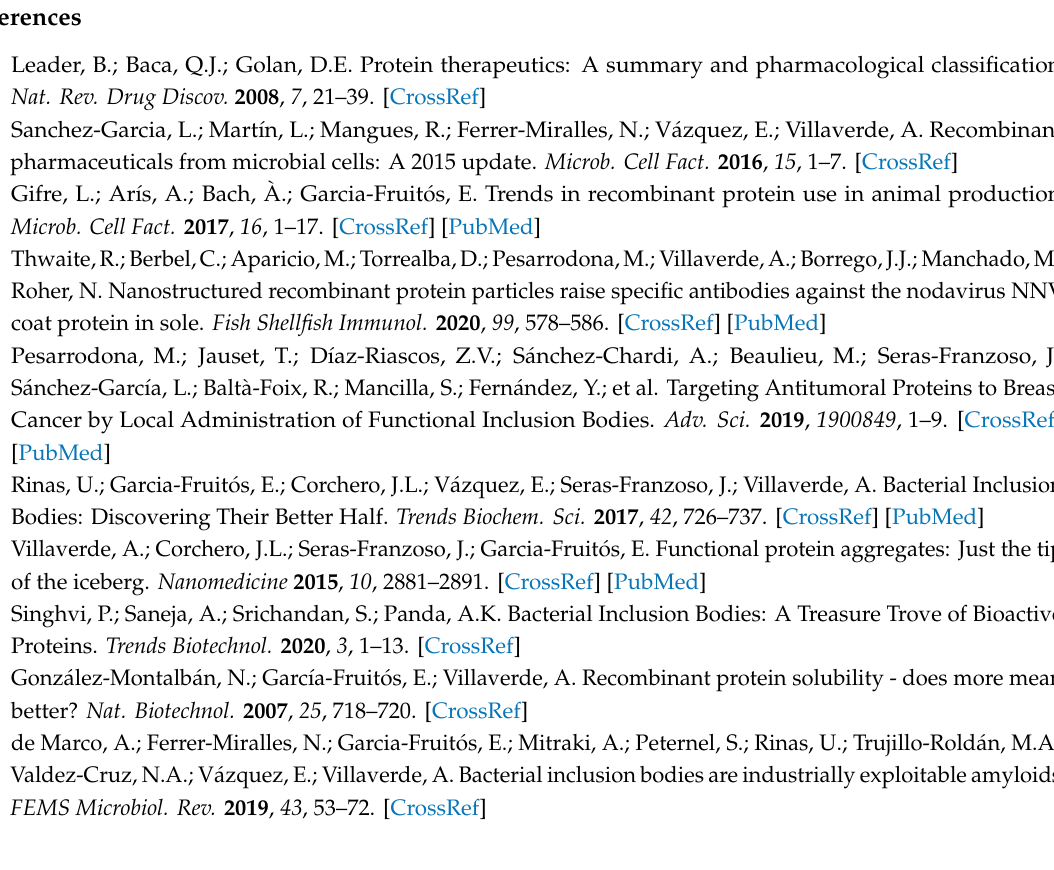
Figure S1: Schematic representation of the protocol used to obtain MMP-9 in L. lactis in both soluble and IB formats. Table S1. Detailed output for the statistical analyses in Figure 2a in the main manuscript. Di ff erent letters depict di ff erences between di ff erent treatments and time points. Table S2. Detailed output for the statistical analyses in Figure 2b in the main manuscript. Di ff erent letters depict di ff erences between di ff erent treatments and time points. Table S3. Detailed output for the statistical analyses in Figure 3 in the main manuscript. Di ff erent letters depict di ff erences between di ff erent treatments and time